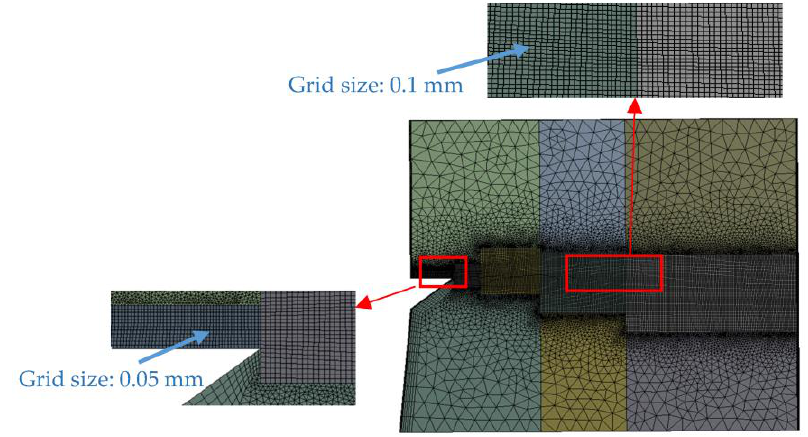
Figure 3. Two-dimensional representation of grid division on the central vertical plane in the radial direction of the computation domain in the three-dimensional CFD model.